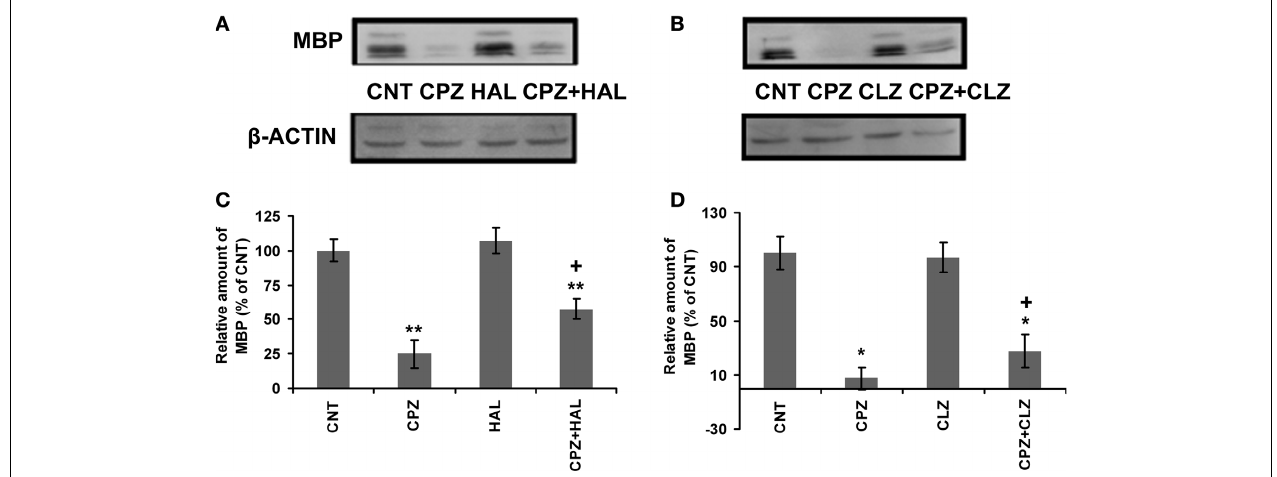
FIGURE 5 | Effects of HAL and CLZ on the CPZ-induced decrease in MBP in PFC. Control and experimentally treated C57BL/6 mice were sacrifi ced on 43rd day after CPZ-exposure. The PFC was dissected out of the brain and processed for Western-blot analysis to measure MBP levels. The upper photographs (A) and (B) are representative Western-blots from HAL and CLZ